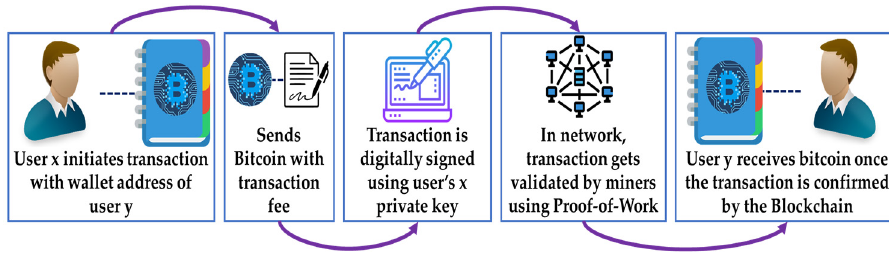
Figure 5. Peer-to-peer transactions in bitcoin.